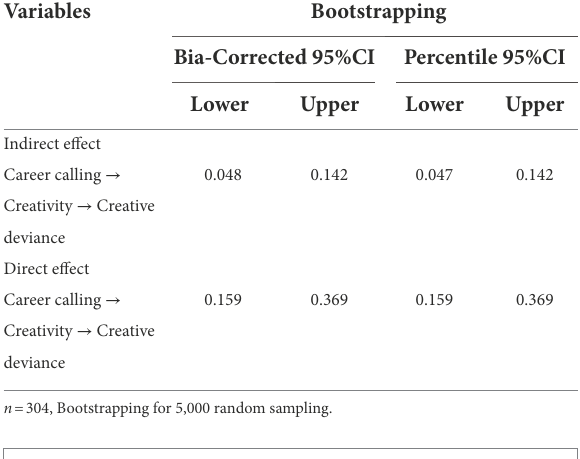
TABLE 4 The mediating effect test.